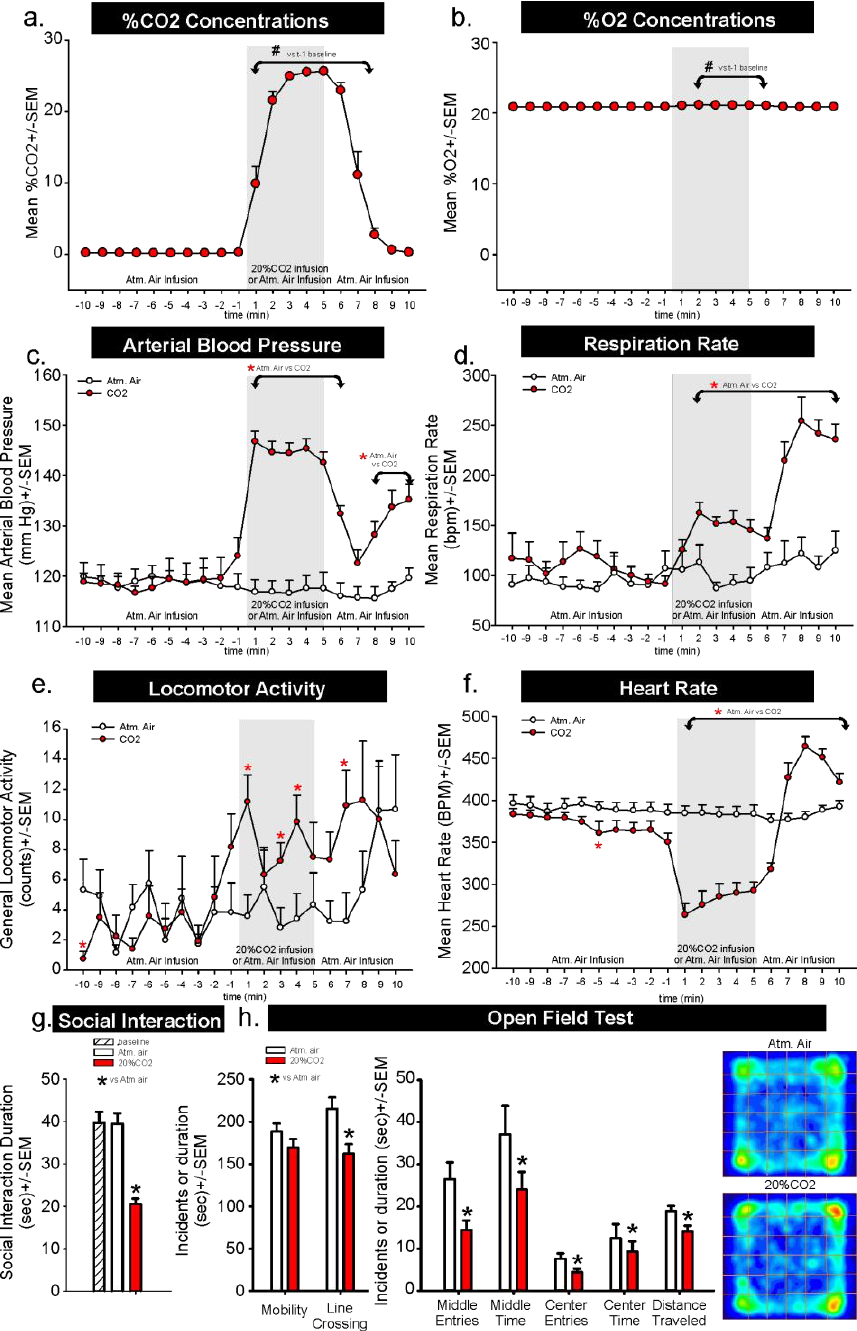
Figure 1. Line graphs in ( a – f ) respectively represent ambient concentrations of CO 2 and O 2 ; mean arterial blood pressure (mmHg); respiration rate (breaths per minute); general locomotor activity; and heart rate (beats per minute) at baseline during 10 min atm. air infusion (all rats), then also during either a 5 min atm. air challenge or 20% CO 2 challenge (gray shaded region) following by all rats receiving another 5 min atm. * represents between-subject significance p < 0.05 with a Fisher’s LSD post hoc test protected by a significant one way ANOVA with gas treatment as the main factor and time as a repeated measure. # symbol in a-b represent significant p <0 .05 within subject over time effects (against t-1 min) from a Dunnett’s post hoc test. * symbol in ( e ) represents between subjects significance p < 0.05 with a two-tailed Dunnett’s post hoc test protected by a significant one-way ANOVA with gas treatment as the main factor. * in ( f ) represents between-subject significance with a two-tailed paired t -test. Behavior testing immediately following gas challenges were ( g ) social interaction duration, and ( h ) open field behaviors.